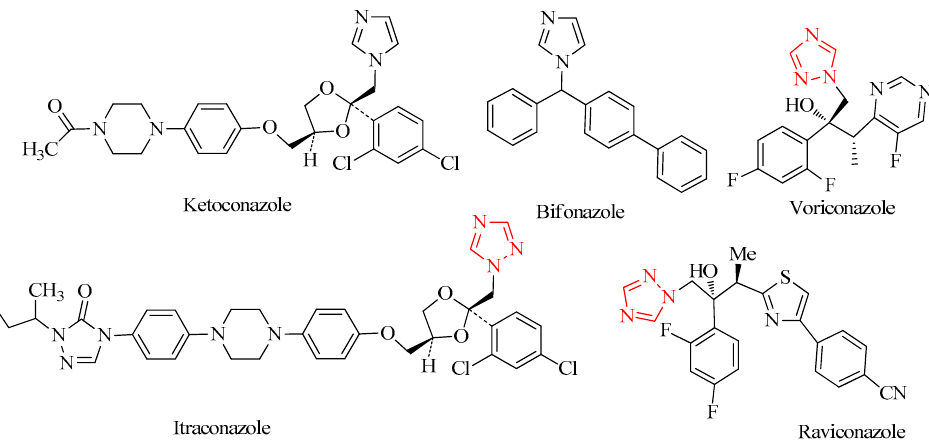
Figure 1. Selected pharmaceutically relevant azoles derivatives and 1,2,4-triazoles emphasized by a red color. Extensive use and long-term therapy with azoles resulted in fungal resistance